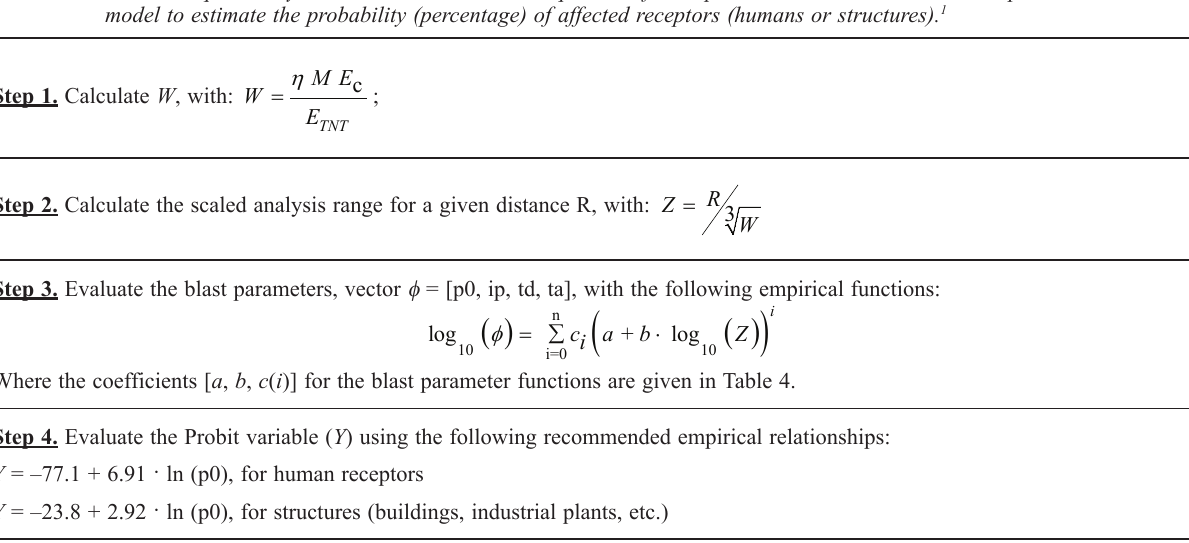
Table 3 – The TNT equivalency model to estimate the consequences of an explosion. The TNT model was completed with the Probit model to estimate the probability (percentage) of affected receptors (humans or structures). 1